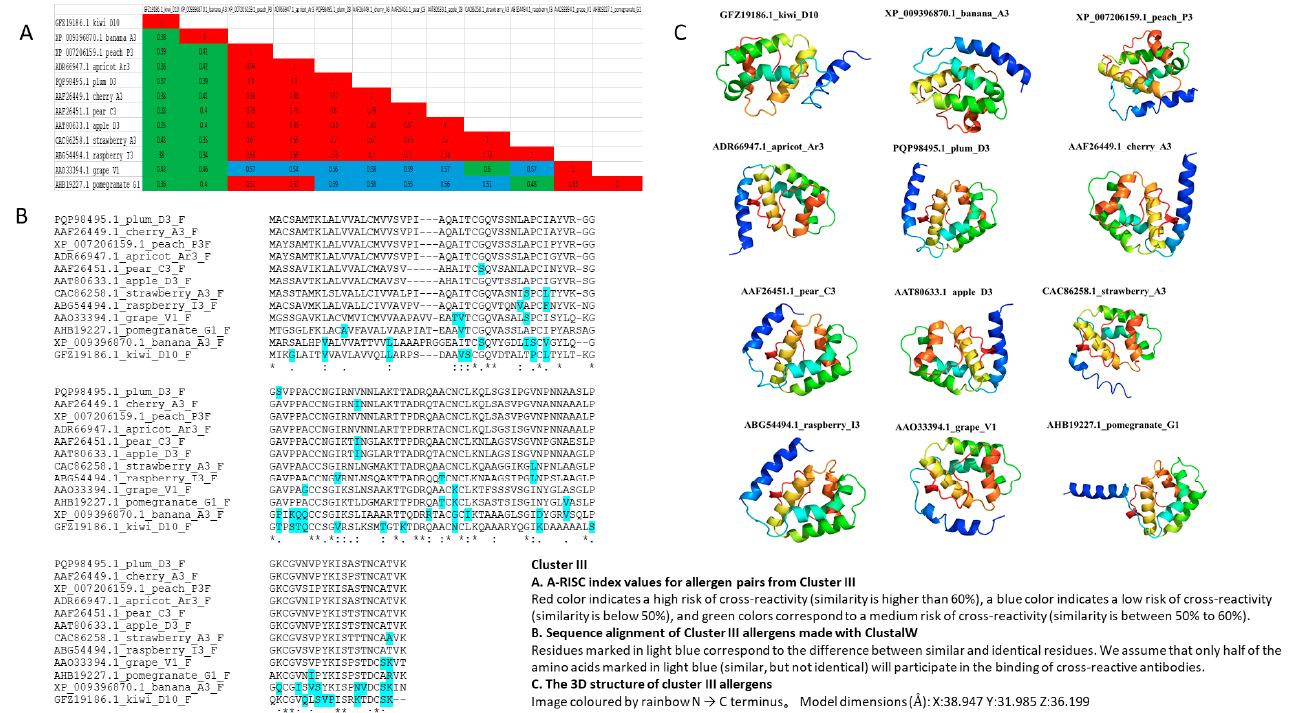
Figure 4. A-RISC index values, sequence alignment, and 3D structure of Cluster